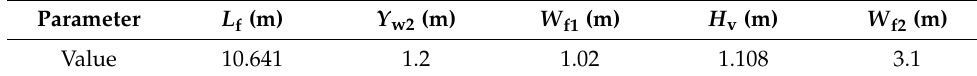
Figure 6. Details of the wing 1 model. Table 2. Main dimensions of wing 1. Parameter